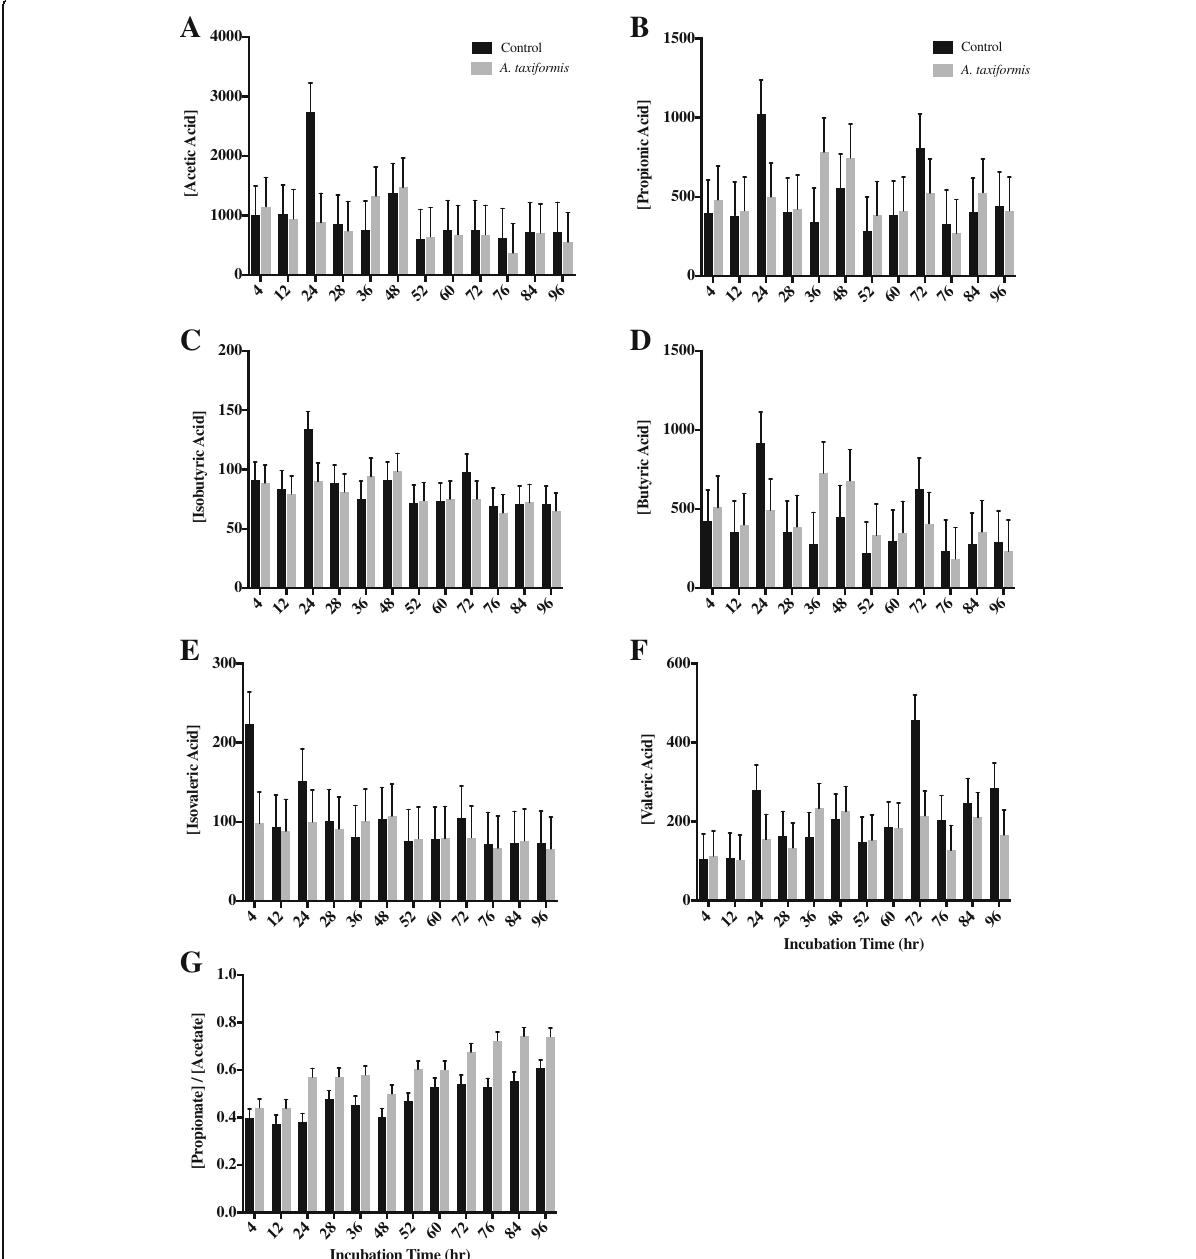
Fig. 3 Volatile fatty acid production during in-vitro fermentation. Volatile fatty acid concentrations [ppm] of fermentation fluid of vessels without (n = 3) and with (n = 3) A. taxiformis as additive, determined 4, 12, and 24 h after feeding over 4 days. a Acetic acid; b Propionic acid; c Isobutyric acid; d Butyric acid; e Isovaleric acid f Valeric acid; g Propionate/Acetate Ratio. Measurement were performed in